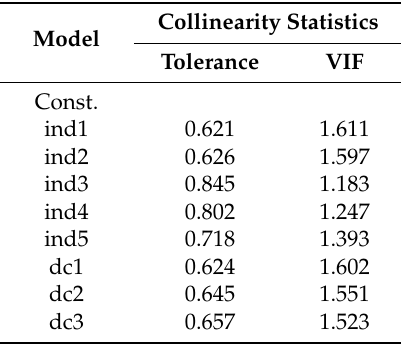
Table 3. Results of the values for tolerance and VIF from multiple regression analysis.